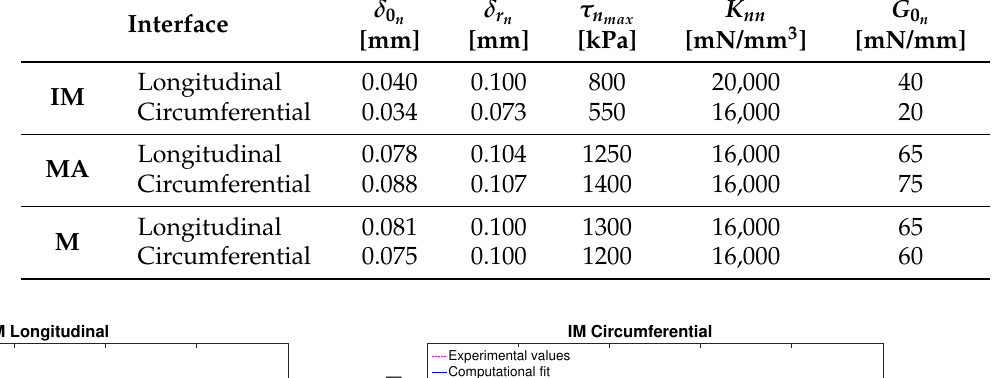
Table 4. Normal cohesive material parameters obtained by the fitting of the mixed test and used to model normal failure at the interface.